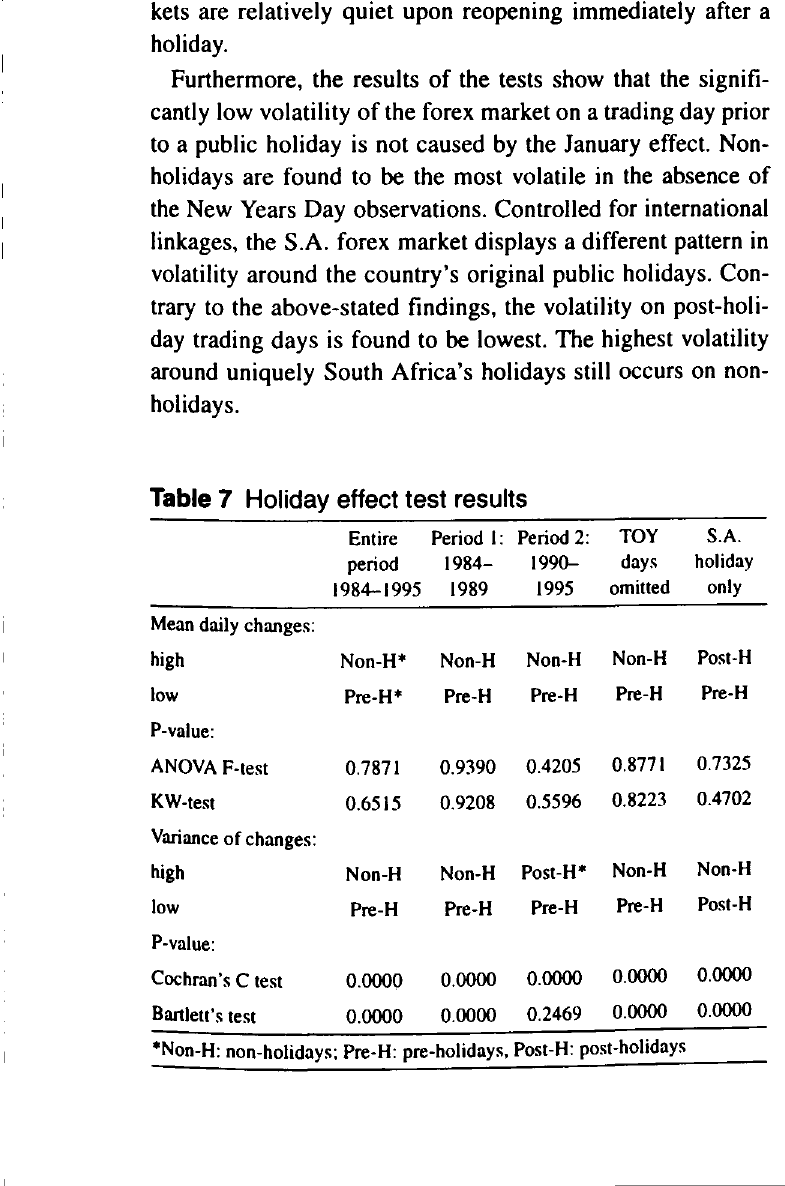
Table 7 Holiday effect test